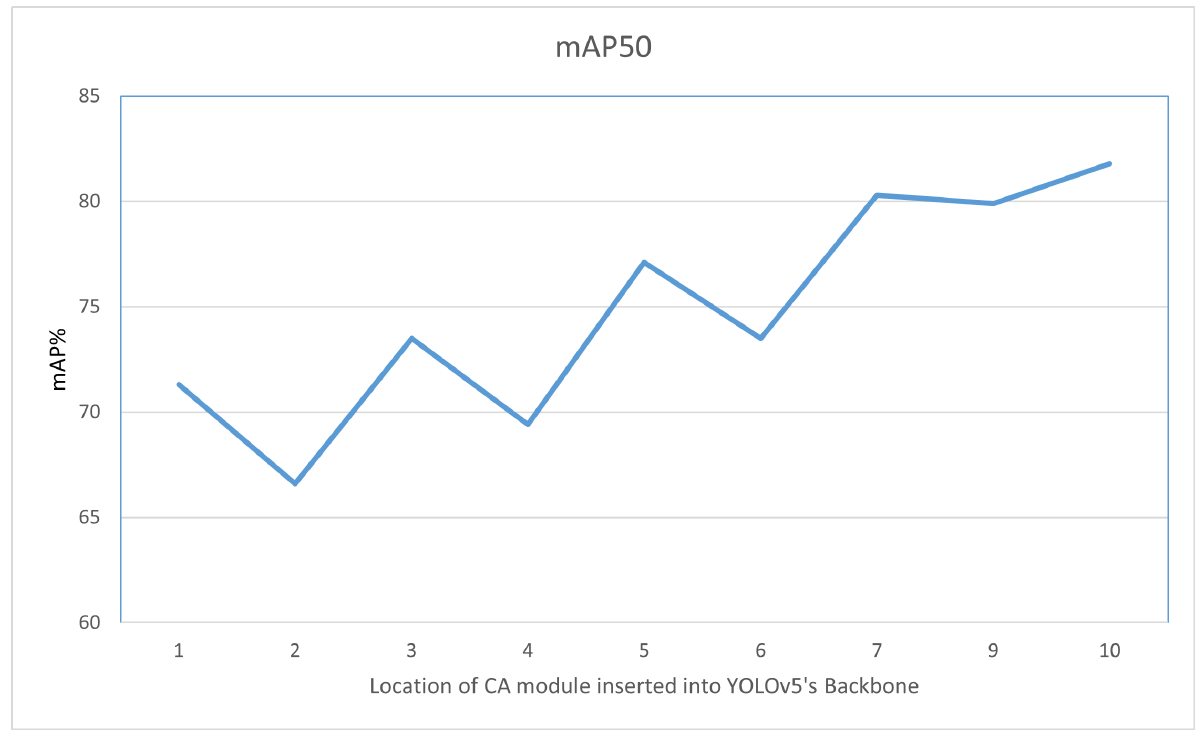
Figure 3. The impact of coordinate attention on accuracy when inserted into YOLOv5’s Backbone.